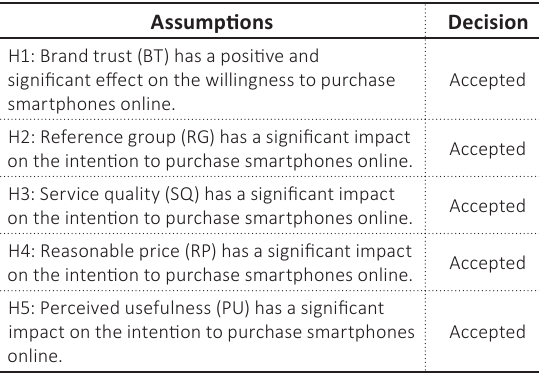
Table 3. Summary of hypotheses testing